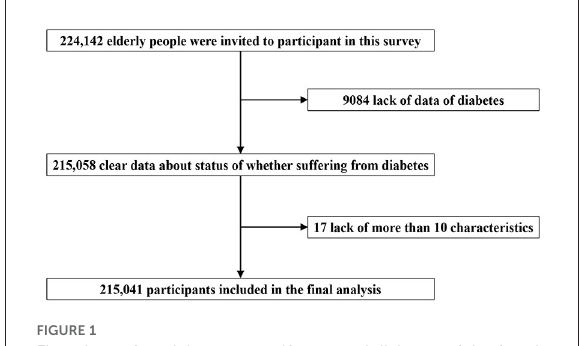
FIGURE1 Flowchart of participants on self-reported diabetes of the fourth SSAPUR study.